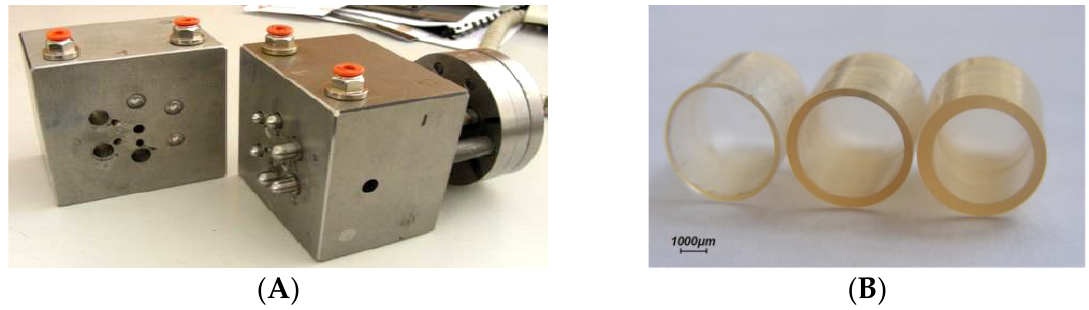
Figure 26. Photographs of the mold set for fabrication of Chronocap ™ capsule shells by injection- molding ( A ) and capsules bodies based on HPC (Klucel ® LF) having 300, 600 and 900 µm thickness ( B ). Adapted with permission from Ref. [67].